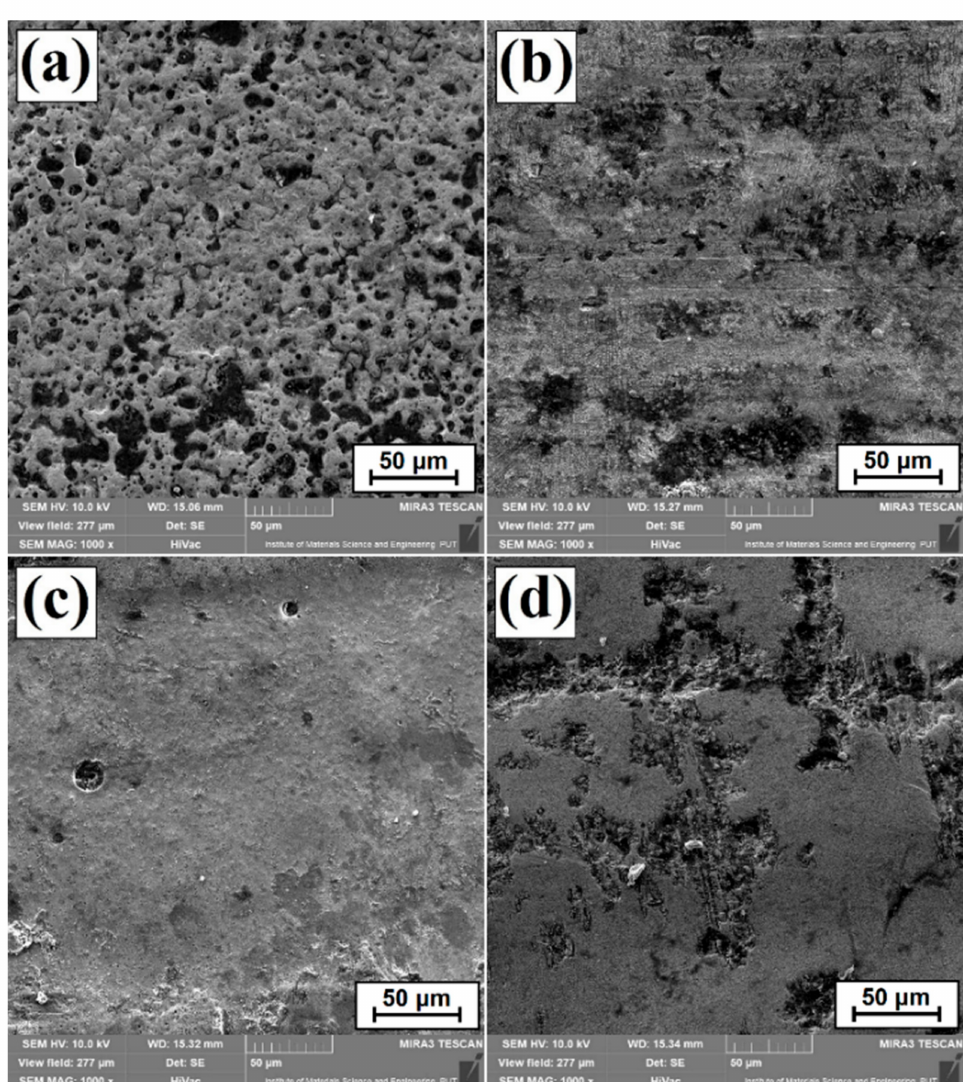
Figure 9. Surface condition after corrosion resistance tests for ( a ) diffusion borochromized layer, ( b ) B-Cr coatings produced using 600 W, ( c ) B-Cr coatings produced using 900 W, and ( d ) B-Cr coatings produced using 1200